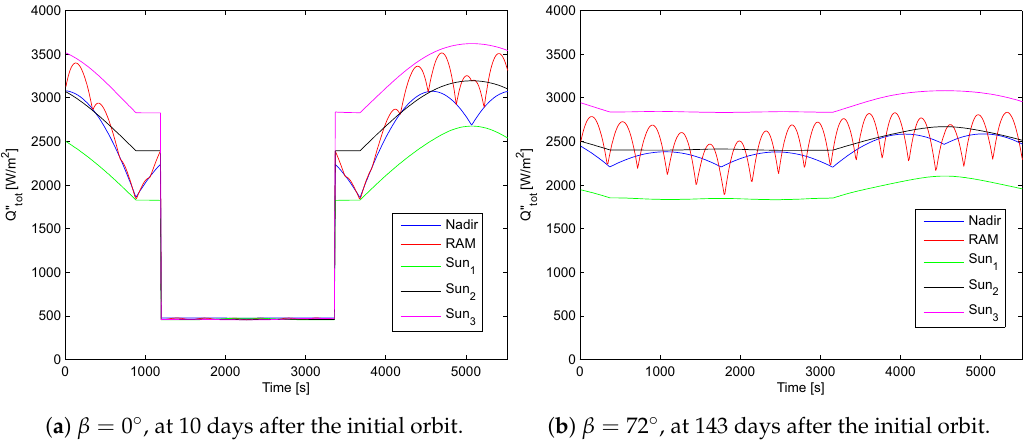
( a ) β = 0 ◦ , at 10 days after the initial orbit. ( b ) β = 72 ◦ , at 143 days after the initial orbit. Figure 11. Total irradiance flux for each attitude, with TLE1 and perturbation “Drag: NLMSISE-00, J 2